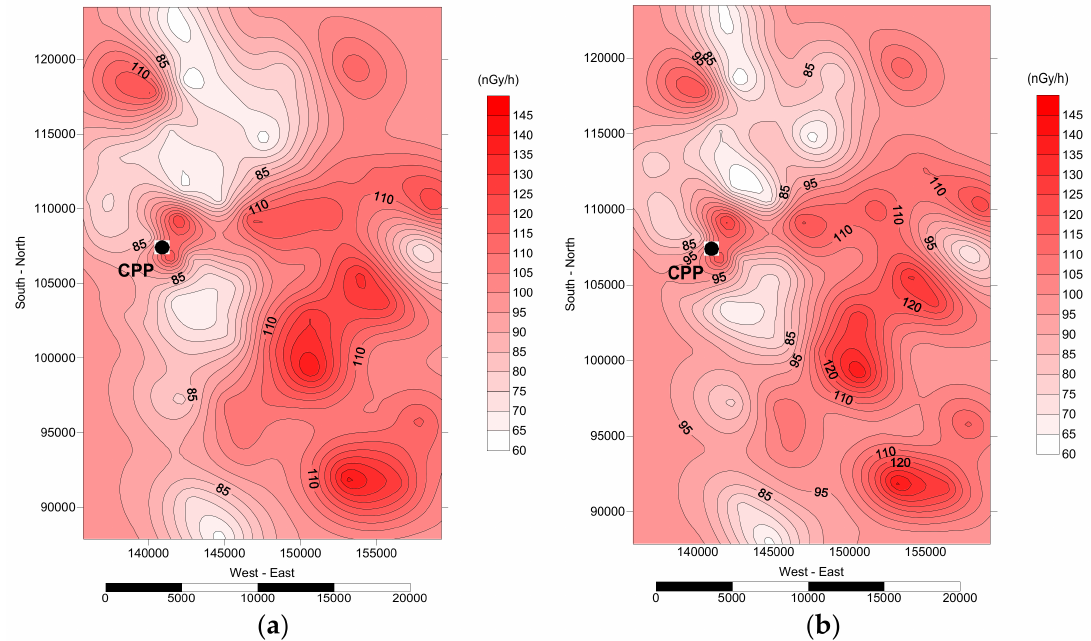
Figure 3. Spatial distribution of gamma dose rates, in nGy/h, for ( a ) SC1 and ( b ) SC2.. The represented data refers to the terrestrial component only, obtained by subtracting, to each measured value, the cosmic component obtained as proposed by [42] using the altitude over the sea of each sampling